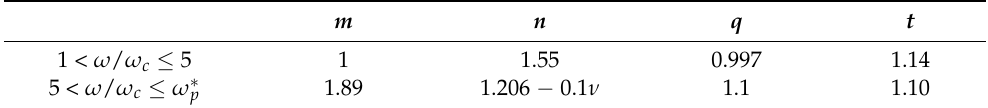
Table 8. Parameters in Equations (15) and